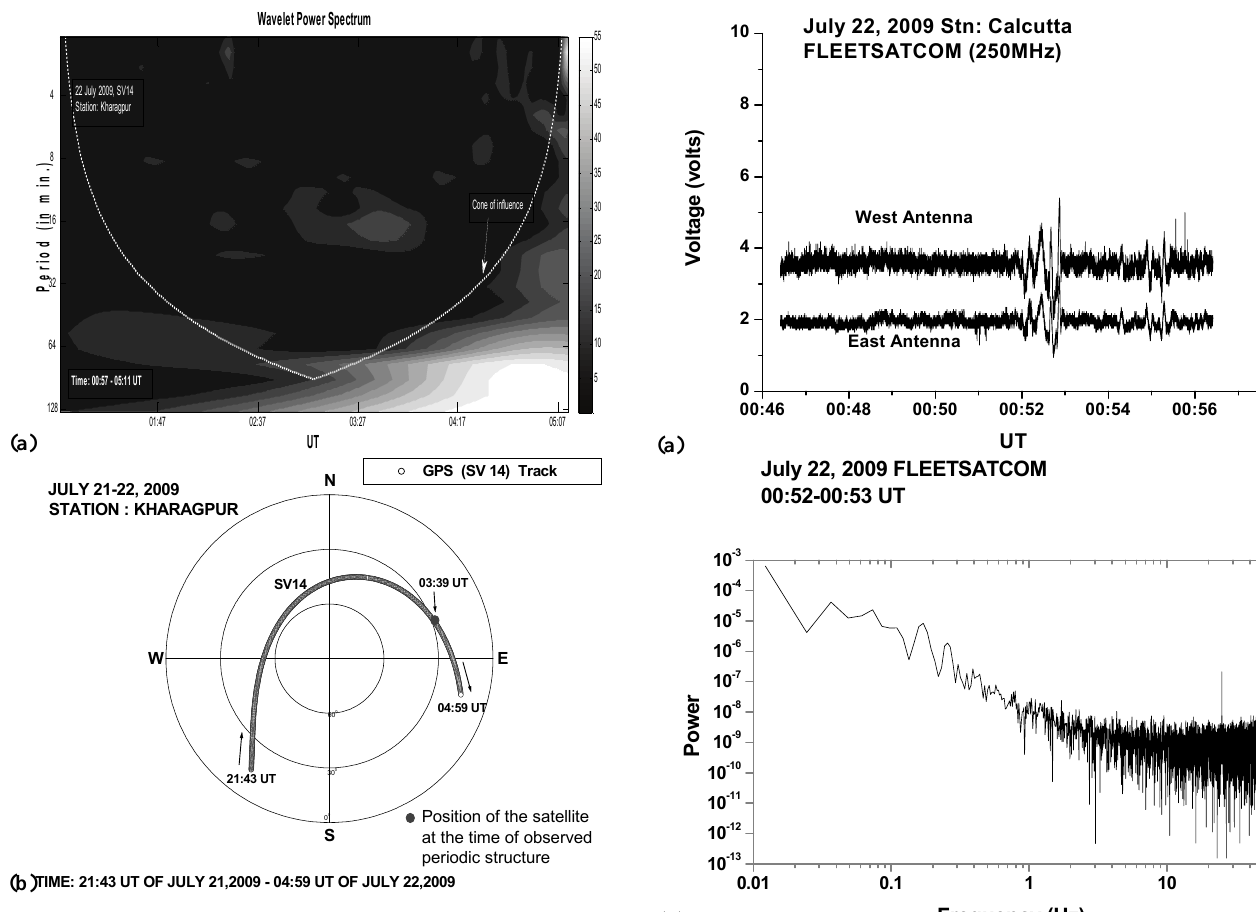
Fig. 8. Wavelet transform corresponding to deviations of the slant TEC from the 90-min moving average recorded on the SV14 link during a period 00:57–05:11UT on 22 July 2009 is shown in (a) . Periodic structures of period about 16.6min corresponding to the eye of the contour were indicated by the wavelet transform applica- tion around 03:39UT. At that time, the satellite was located north- east of Kharagpur as evident from the polar plot of (b) . The white dotted line indicates the cone of influence within which results are reliable.